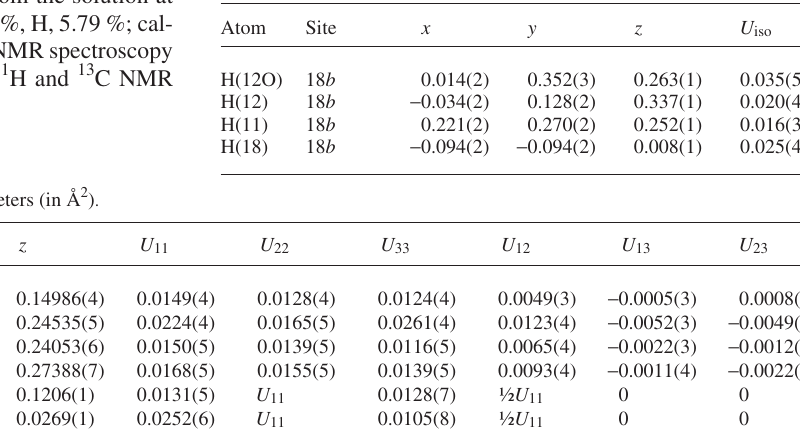
Table 2. Atomic coordinates and displacement parameters (in Å 2 ) .